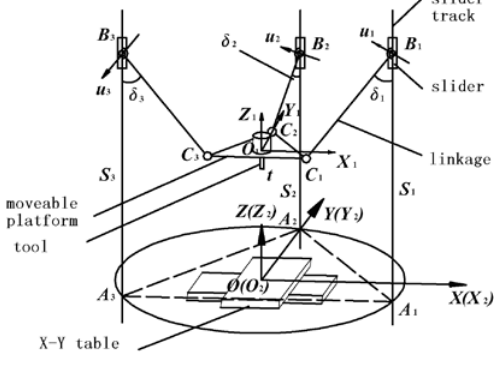
Fig. 1. Coordinate system of PRS-XY hybrid machine